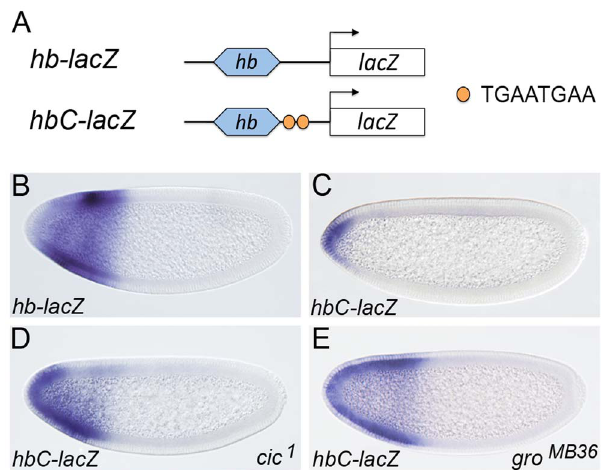
Fig. 2. Cic binding sites are sufficient for recruitment of Gro in vivo. (A) Diagram of lacZ transgenes under the control of a minimal hb enhancer and canonical Cic binding sites (TGAATGAA). (B-E) mRNA expression patterns of hb-lacZ and hbC-lacZ in otherwise wild-type (B, C), cic 1 (D) or gro MB36 (E) mutant embryos; note the strong derepression of hbC-lacZ in both mutant backgrounds. In this and subsequent figures, anterior is to the left and dorsal is up.